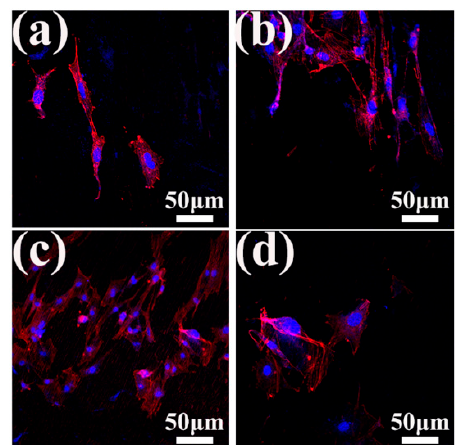
Figure 9. Adhesion and proliferation of MC3T3-E1 cells grown on different sample surfaces. ( a ) The